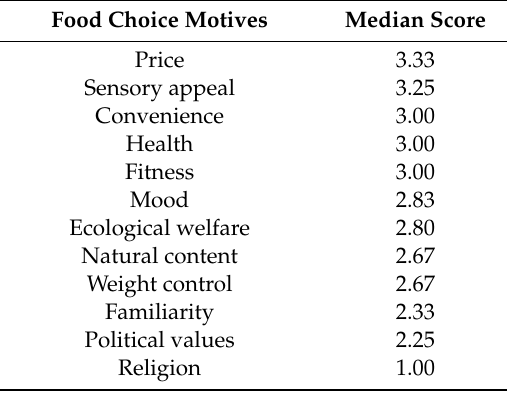
Table 2. Median score for FCMs.